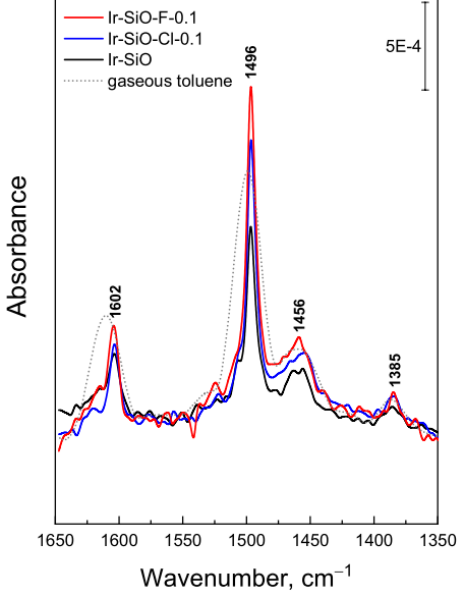
Figure 11. FTIR spectra of gaseous toluene and toluene adsorbed on the surface of iridium cata- lysts.